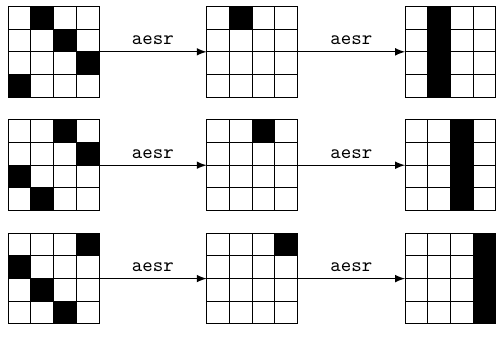
Figure 7: Other possible differential